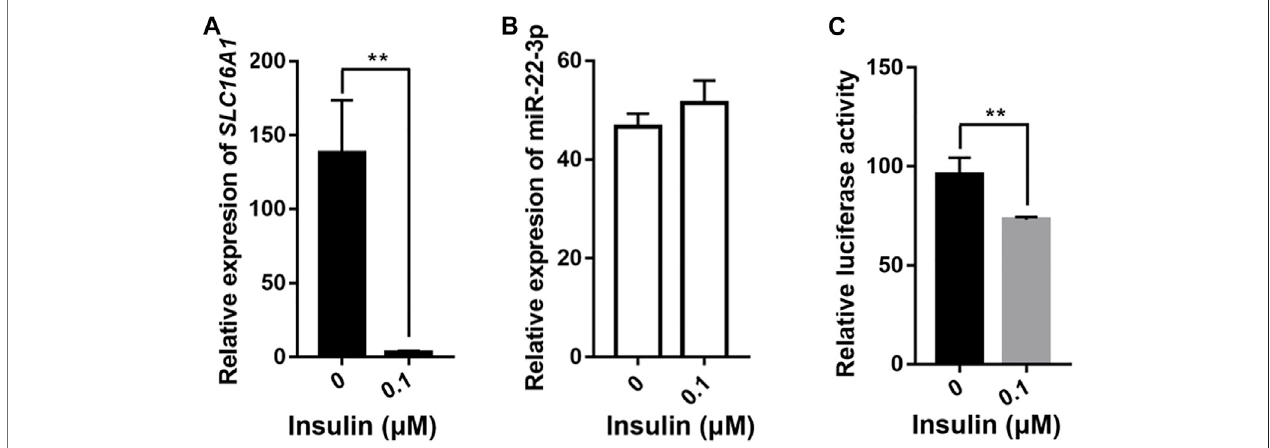
FIGURE 7 | Effect of insulin on expression of SLC16A1 and miR-22-3p. QPCR assays of (A) SLC16A1 and (B) miR-22-3p expression in transfected bovine hepatocytes treated with 0.1 μ M insulin for 24 h after 12 h of starvation. (C) Dual-luciferase assay of bovine SLC16A1 promoter activity. n = 5 in each